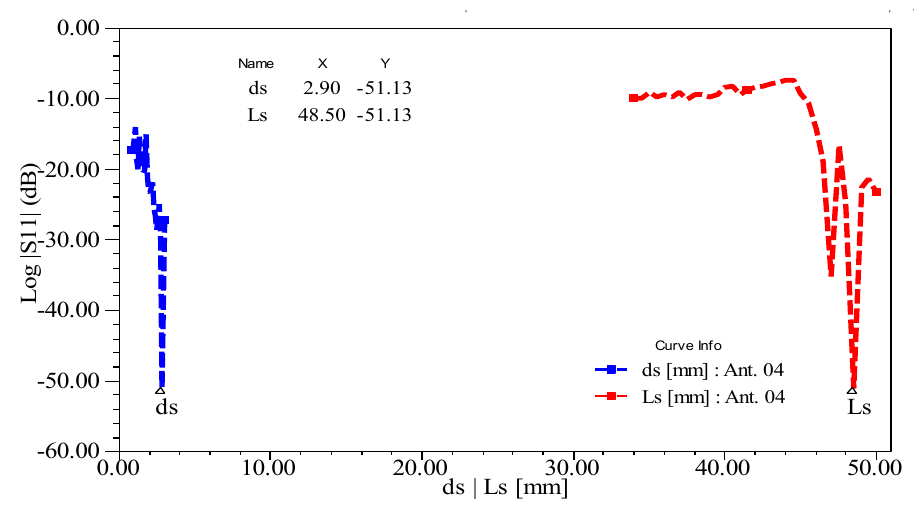
Figure 14. Reflection coefficient of slot antenna 4 at 2450 MHz versus ds and Ls (mm).